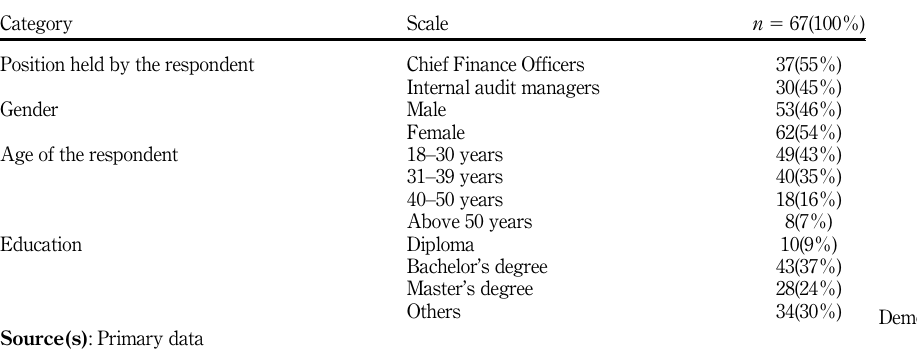
Table 1. Demographic profile